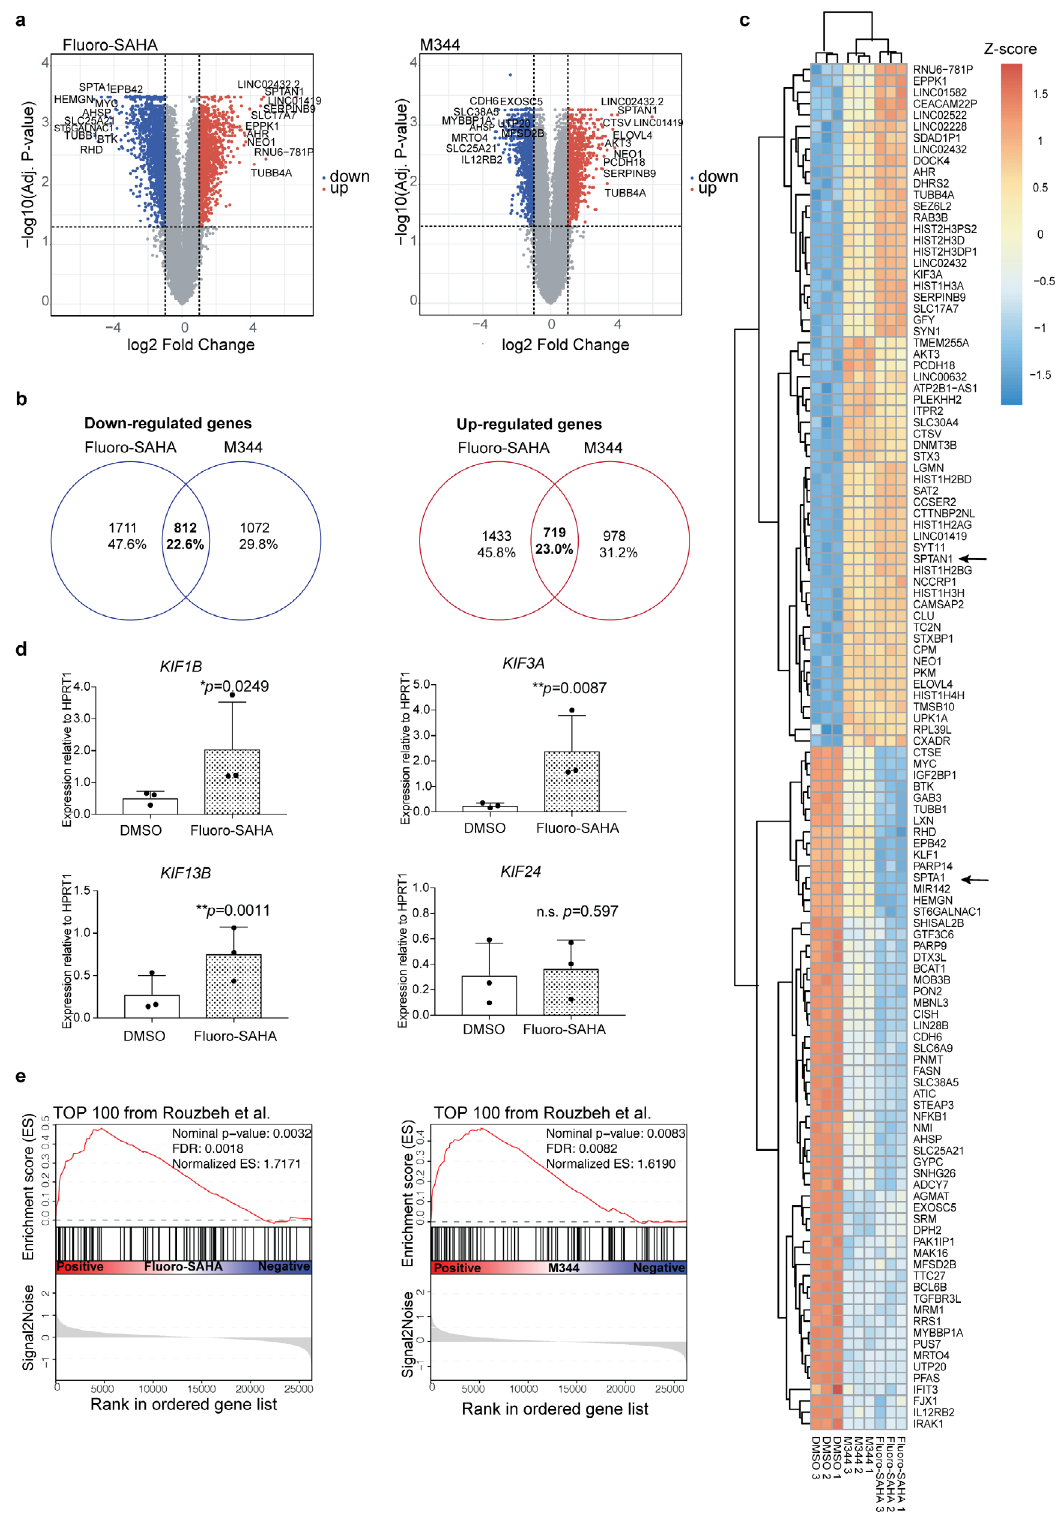
Fig. 6 Gene expression pro fi les of FS- and M344-treated HiDEP cells. a Volcano plots of the microarray data comparing gene expression pro fi les of HiDEP cells treated with Fluoro-SAHA and M344 for 24 h. b Venn diagrams showing overlap of genes down- and upregulated upon Fluoro-SAHA and M344 treatment. The number of genes and frequency within the whole altered genes are shown. c A heatmap of 60 selected genes that are commonly up- and downregulated upon both Fluoro-SAHA and M344 treatment. d qRT-PCR analysis for expression of kinesin genes in HiDEP cells treated with DMSO or Fluoro-SAHA. The expression levels are normalized to HPRT1 . Mean ± SD, n = 3. Signi fi cance was determined using paired t -test. e Gene set enrichment analysis (GSEA) of the microarray data. Enrichment of top 100 genes that are upregulated in erythroblasts differentiated from human iPS cells 37 are shown. * p < 0.05, ** p <